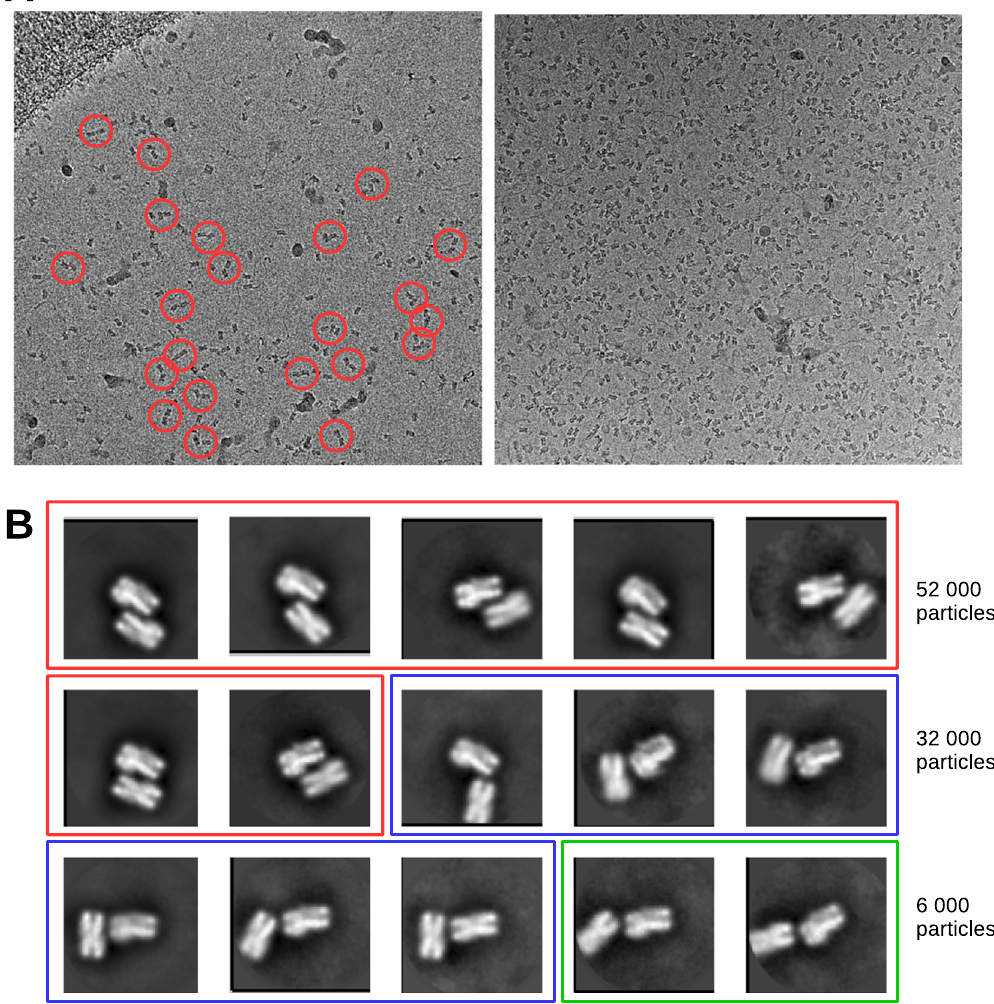
Figure 1. Nucleosome core particle dimers. ( A ) Representative cryo-EM raw micrographs collected on a Falcon II camera with a Titan Halo electron microscope at 300 keV. Many NCP pairs are also visible. Several NCP pairs are depicted by red circles. ( B ) Representative 2D class averages showing pairs of nucleosome core particles in many different orientations. Red area: particles with two histone octamers facing each other. Blue area: particles with the histone octamer facing the DNA of the second NCP. Green area: particles with the two DNA regions of the NCPs facing each. In nearly all cases, the gyre of the DNA around the histone core is